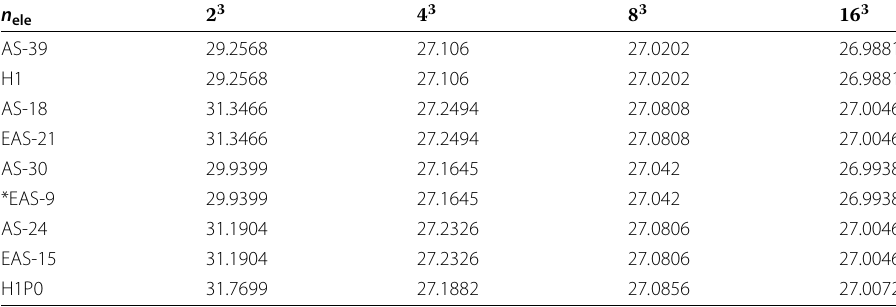
Table 4 Inhomogeneous compression block in linear elasticity